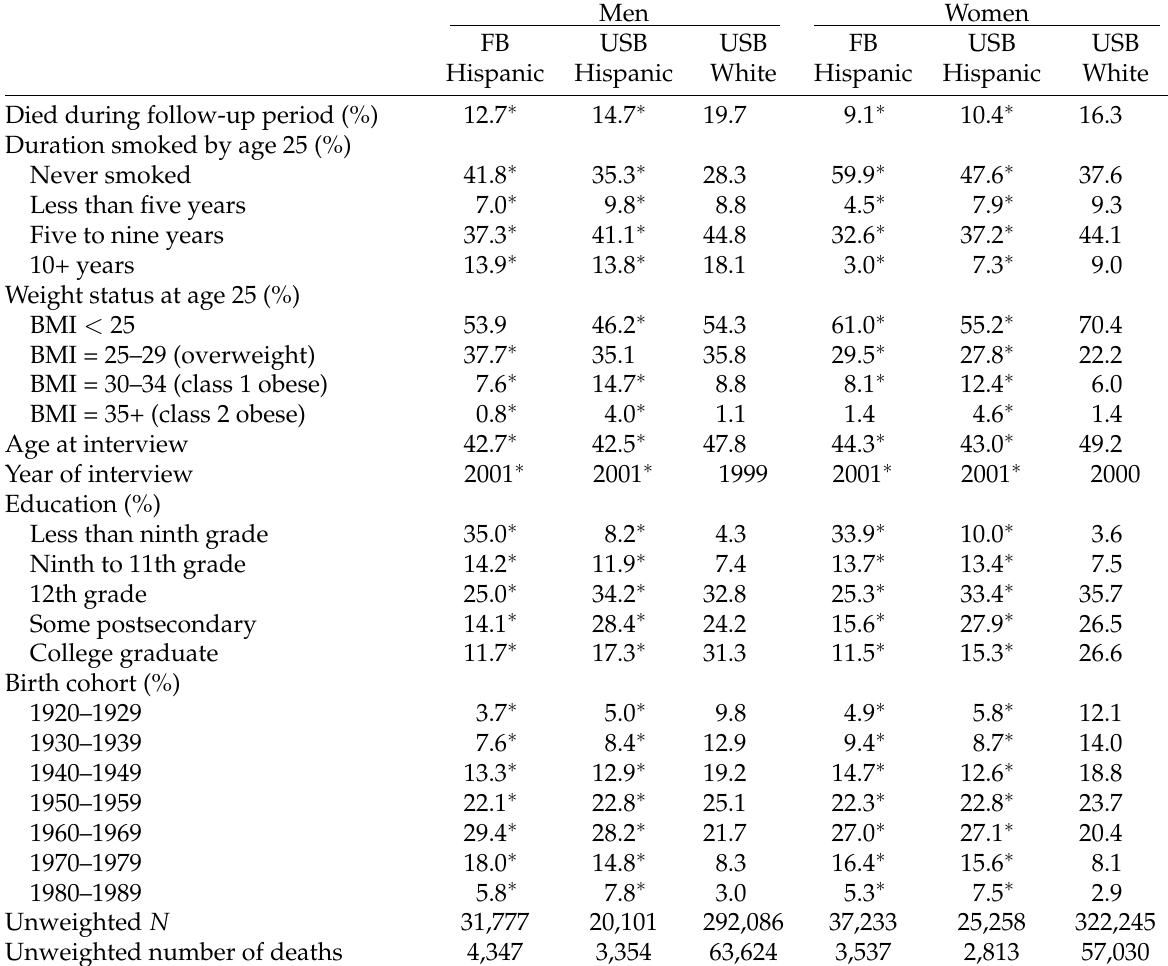
Table 1: Sample descriptives (weighted mean or percentage), by gender and